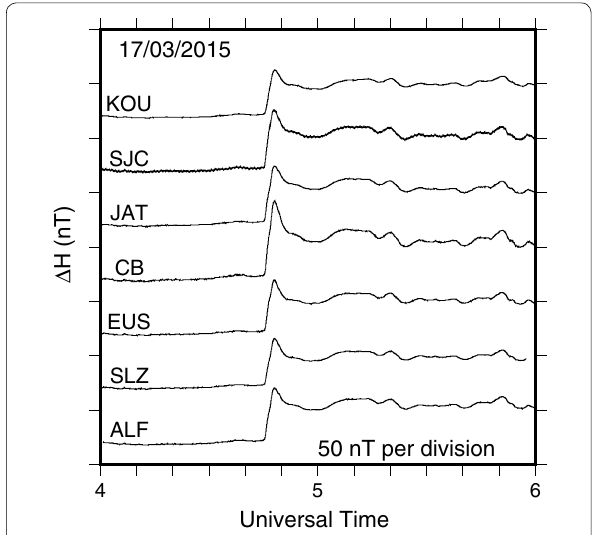
Fig. 4 Time series of the magnetic field H-component at the six EMBRACE stations and KOU geomagnetic observatory in eastern South America during 2 h on March 17, 2015. EMBRACE stations have the following abbreviations, geographic coordinates and magnetic dip angle: Alta Floresta (AFL; 9.87S,